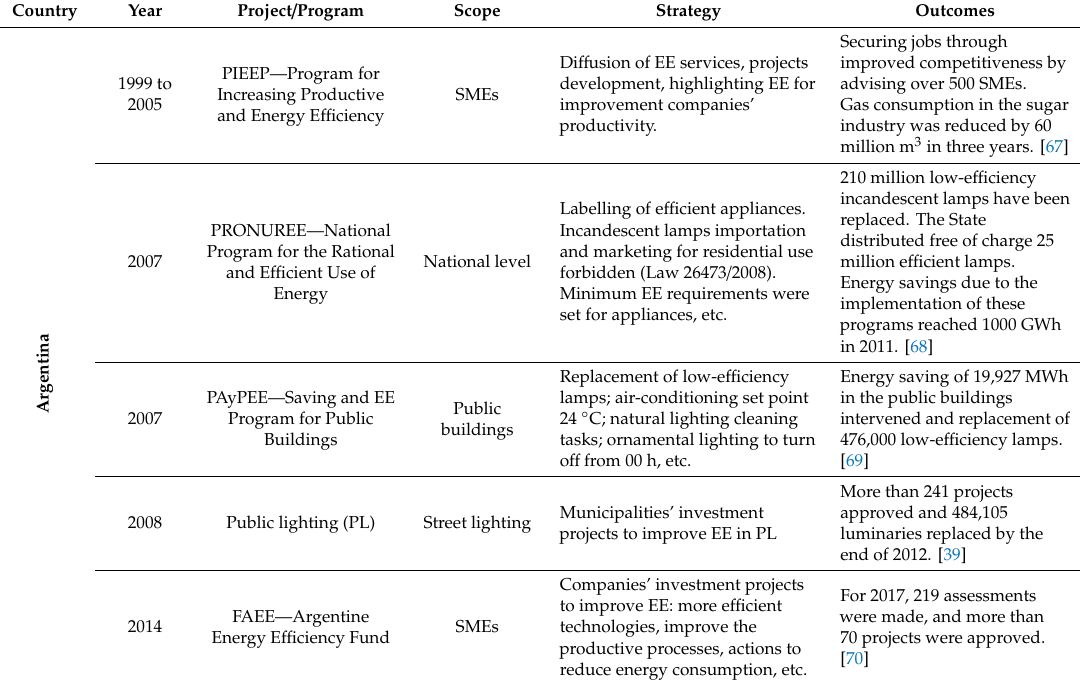
Table 2. Summary of main EE actions developed in South American countries